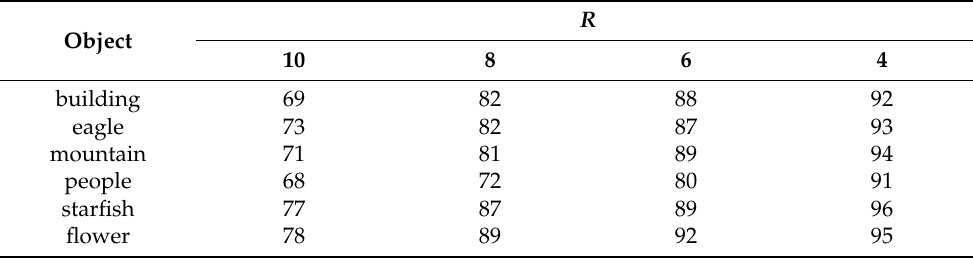
Table 1. Boundary Recall